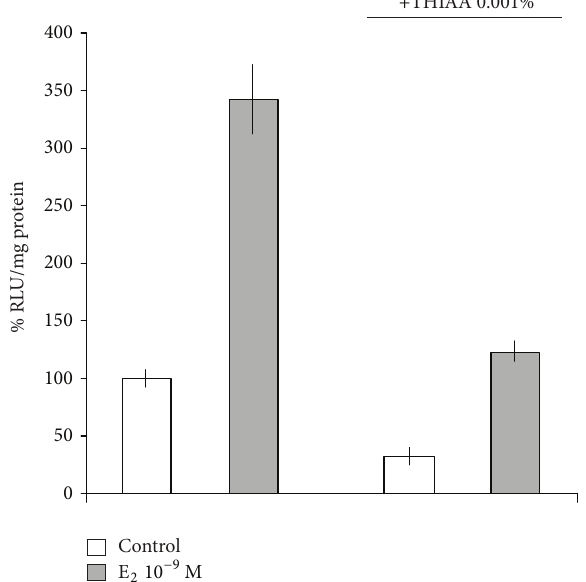
Figure 7: Effect of THIAA on ER 𝛼 -dependent transcription by reporter gene assay in steroid-free culture medium. MVLN cells were incubated for 24 h in the absence (control) or presence of E 2 at 10 −9 M with or without THIAA at 0.001%. Luciferase activity was assayed in cellular extracts by luminometry and emitted light signals were expressed in arbitrary units (relative luciferase units (RLU)) per mg protein. Data refer to the mean value ± SD of an experiment performed in triplicate and are representative of three independent experiments.